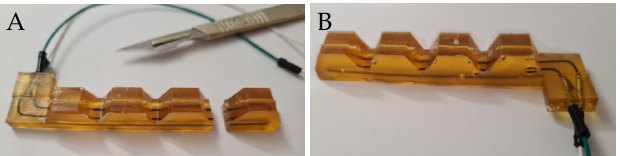
Figure 2. Healing of the robotic finger. The self-healing robotic finger that is developed during this workshop, can heal after being cut in two. It is tendon-driven and has an embedded resistive strain sensor to measure bending. ( A ): Finger cut in two. ( B ): Healed finger with recovered properties.